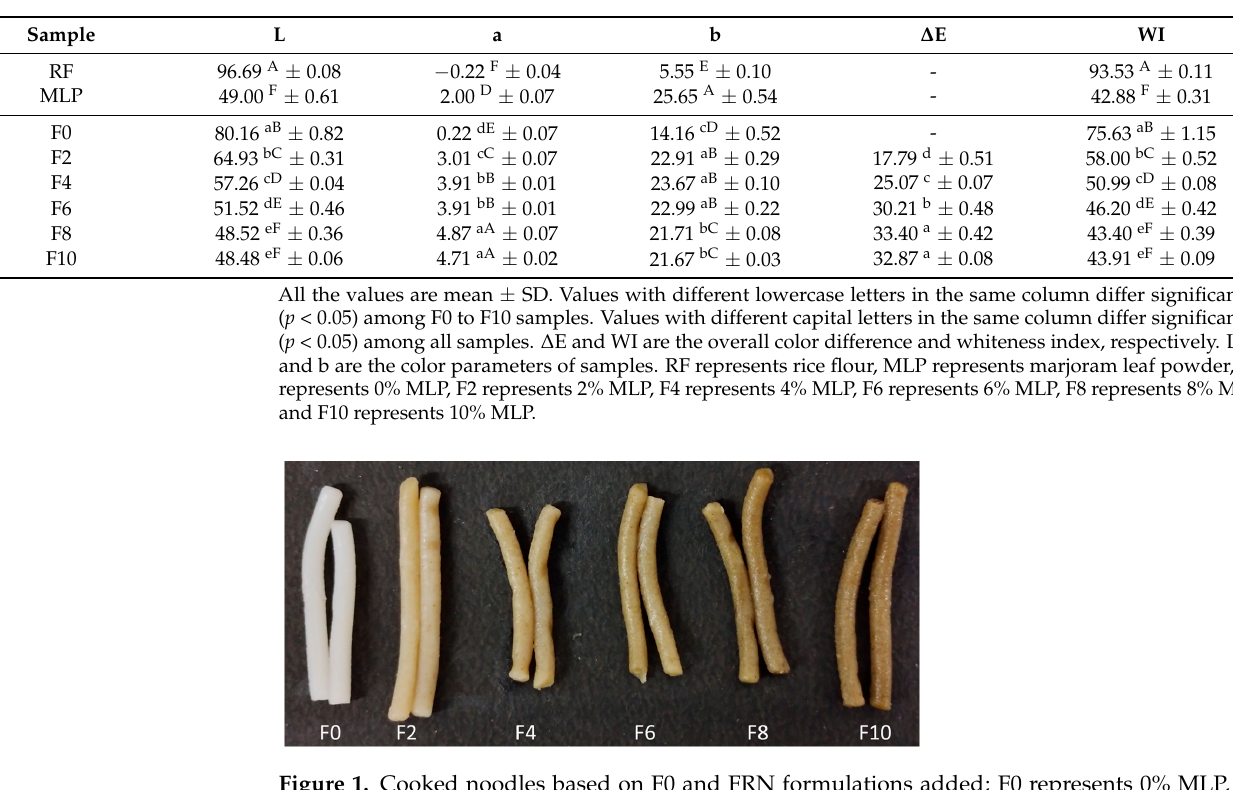
Table 1. Nutritional composition of RF, MLP, F0, and FRNs with different levels of MLP addition .